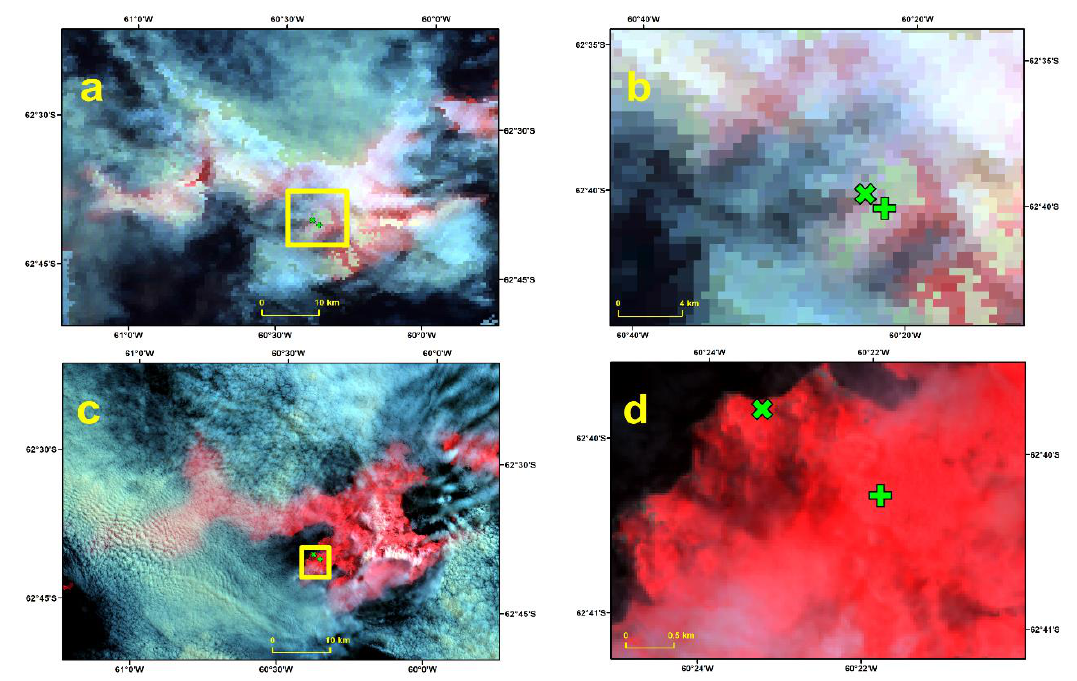
Figure 3. RGB composites of MOD09GA ( a ) and Landsat 8 ( c ) of Livingston Island of December 15 2013. The yellow box shows the area of the close view of the RGB composite of MOD09GA ( b ) and Landsat 8 ( d ) from December 15 2013 in the vicinity of the Automatic Weather Stations. The location of the Automatic Weather Stations at Juan Carlos I and Johnsons Glacier are indicated with a green cross and a green plus sign, respectively. Images provided in the WGS84 UTM20S projection.